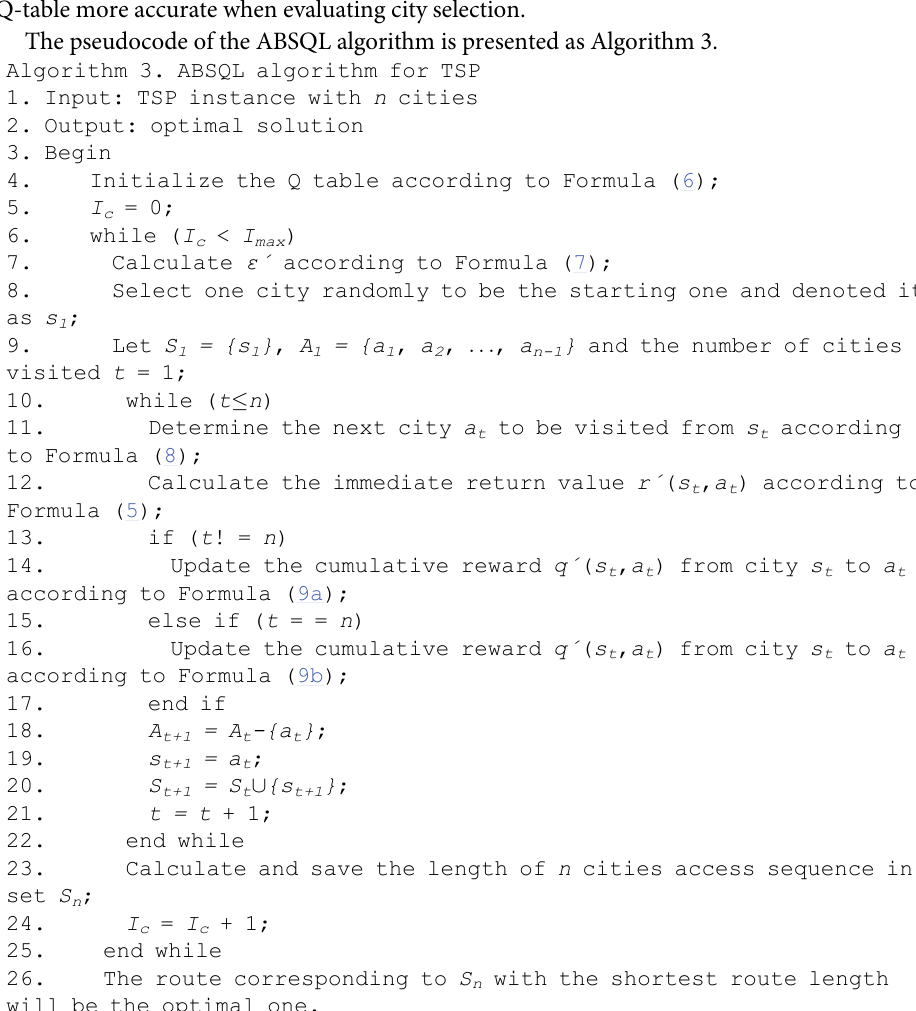
Algorithm 3. ABSQL algorithm for